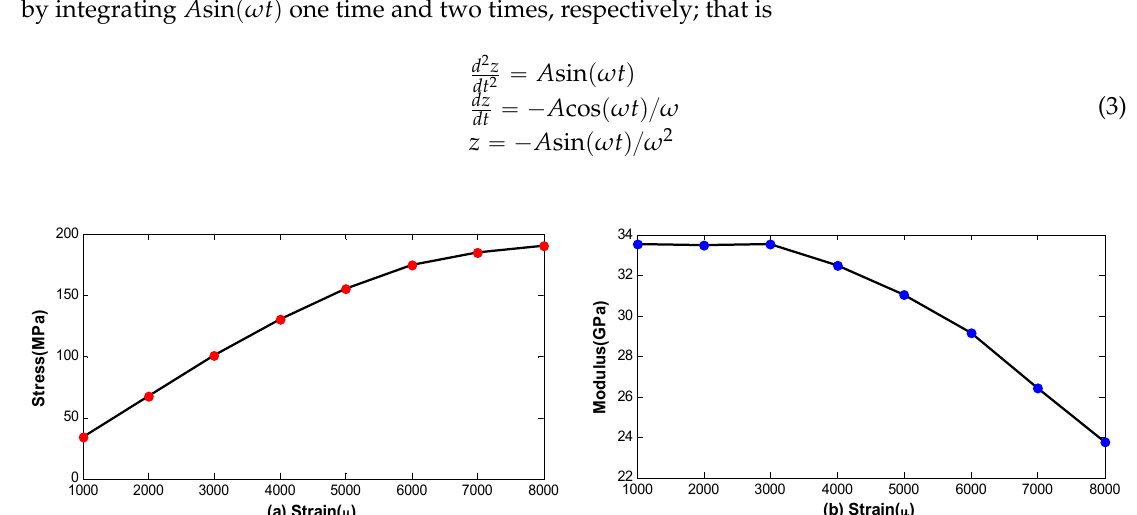
Figure 4. Measurement results of the fiber mechanical properties ( a ) The tensile stress versus the tensile strain; and ( b ) the elastic modulus versus the tensile strain.